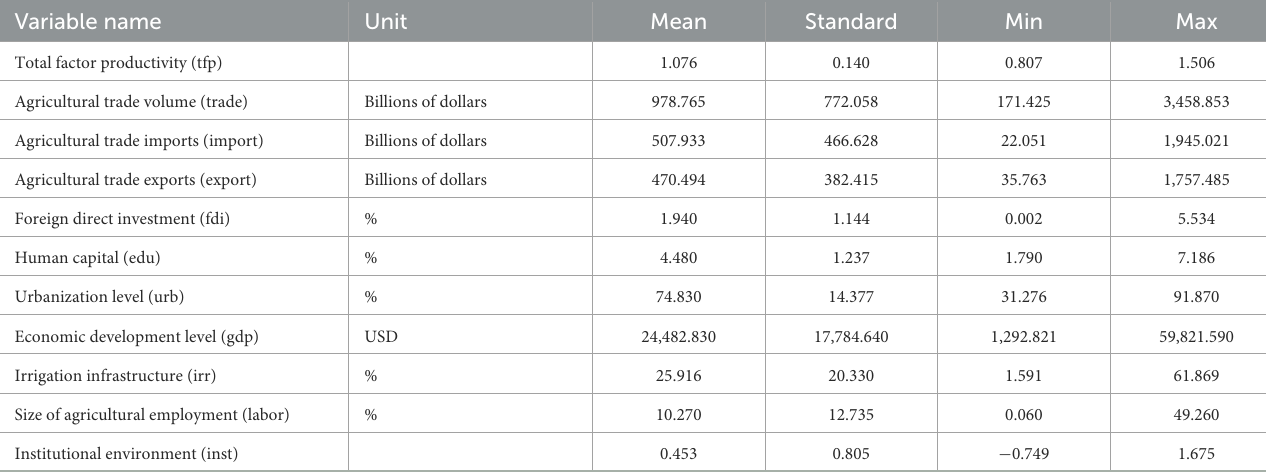
TABLE 3 Descriptive statistics of